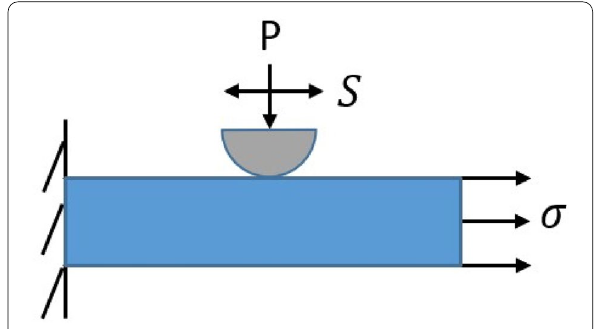
Figure 1 Schematics of the fretting